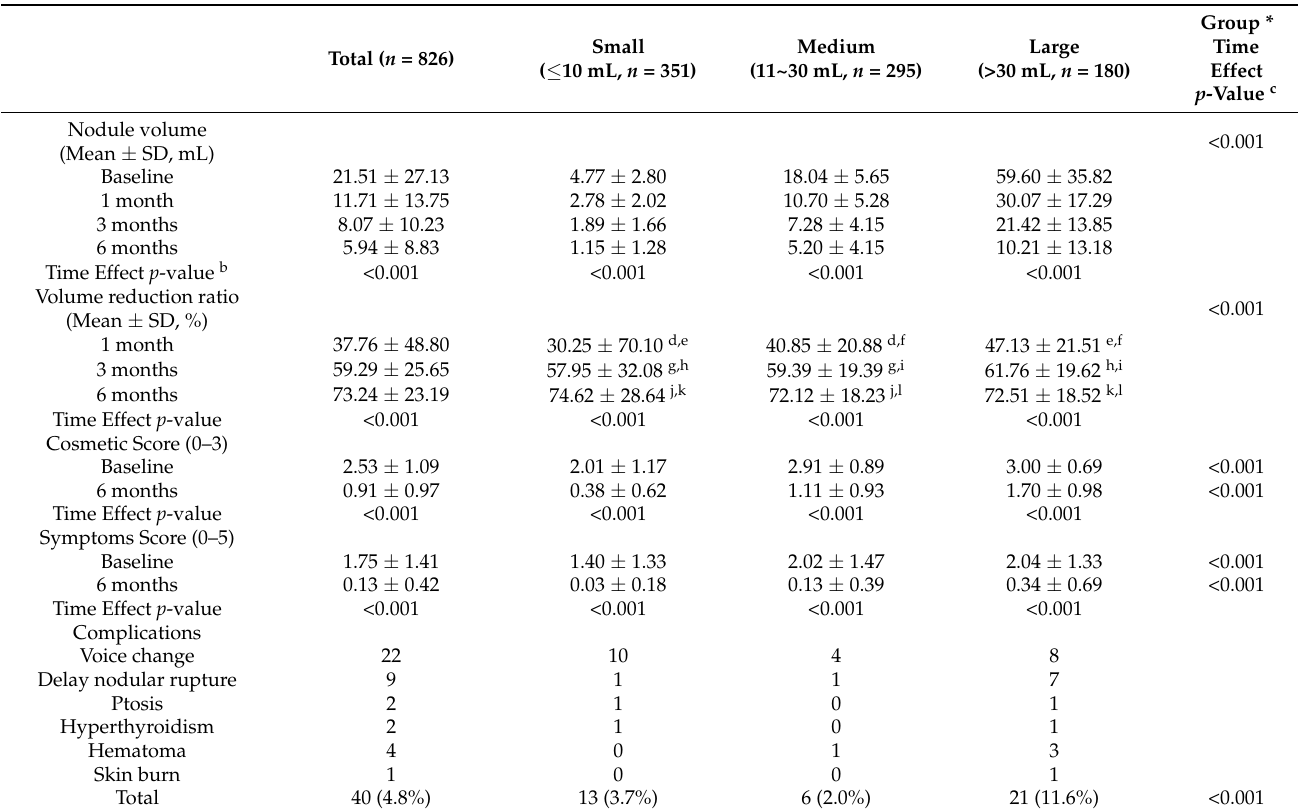
Table 2. Outcomes based on nodule volume a